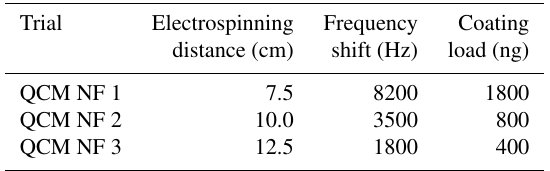
Table 1. Frequency shift and calculated coating load after nanofiber deposition. Trial